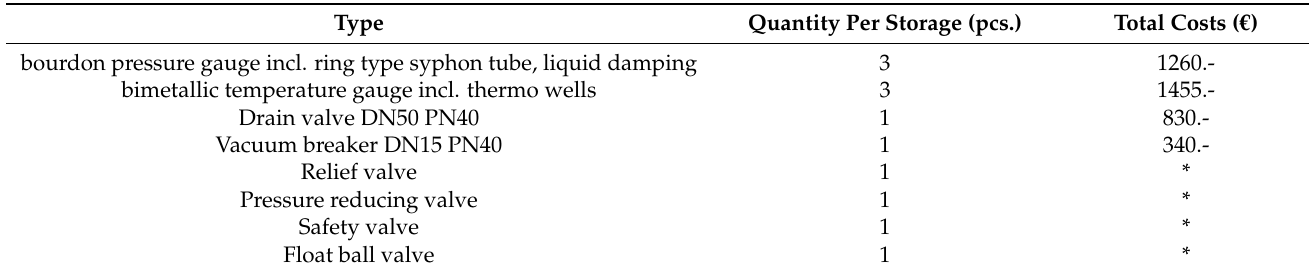
Table 2. Valves and instrumentation considered for Ruths steam storage. Prices are according to [18,23,24]. Type Quantity Per Storage (pcs.) Total Costs ( €